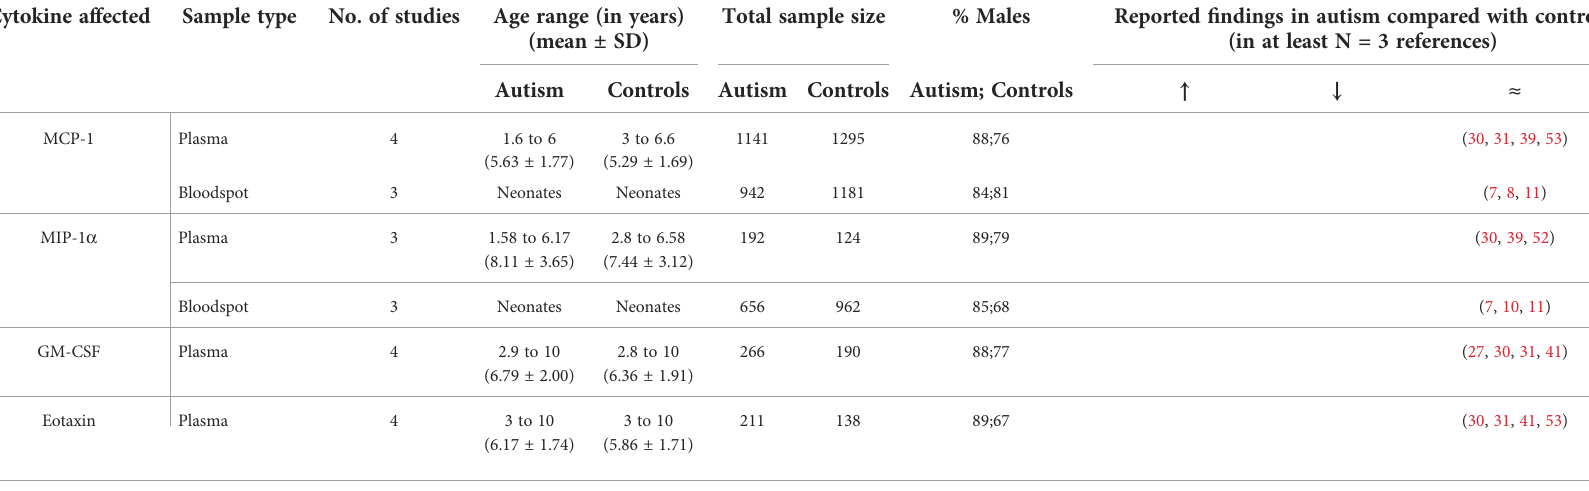
Symbols: ↑ , increased; ↓ , decreased; ≈ , unchanged; in autism compared with controls GM-CSF,granulocyte monocytecolony-stimulatingfactor;IFN- g ,interferon- g ;IL,interleukin;MCP-1,monocytechemoattractant protein-1;MIP-1 a ,macrophagein fl ammatoryprotein;NR,notreported; RANTES,regulated uponactivation,normalTcell expressed and presumably secreted; TGF- b , transforming growth factor- b ; TNF- a , tumor necrosis factor- a